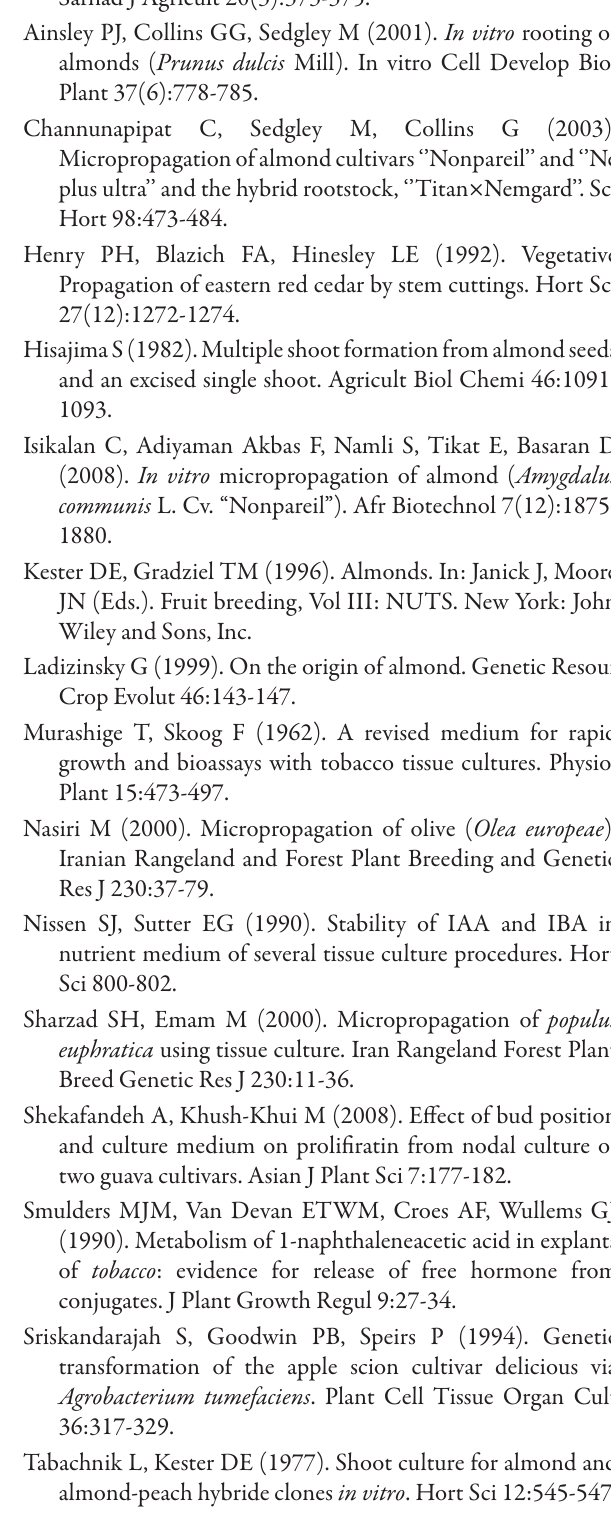
Tabachnik L, Kester DE (1977). Shoot culture for almond and almond-peach hybride clones in vitro . Hort Sci